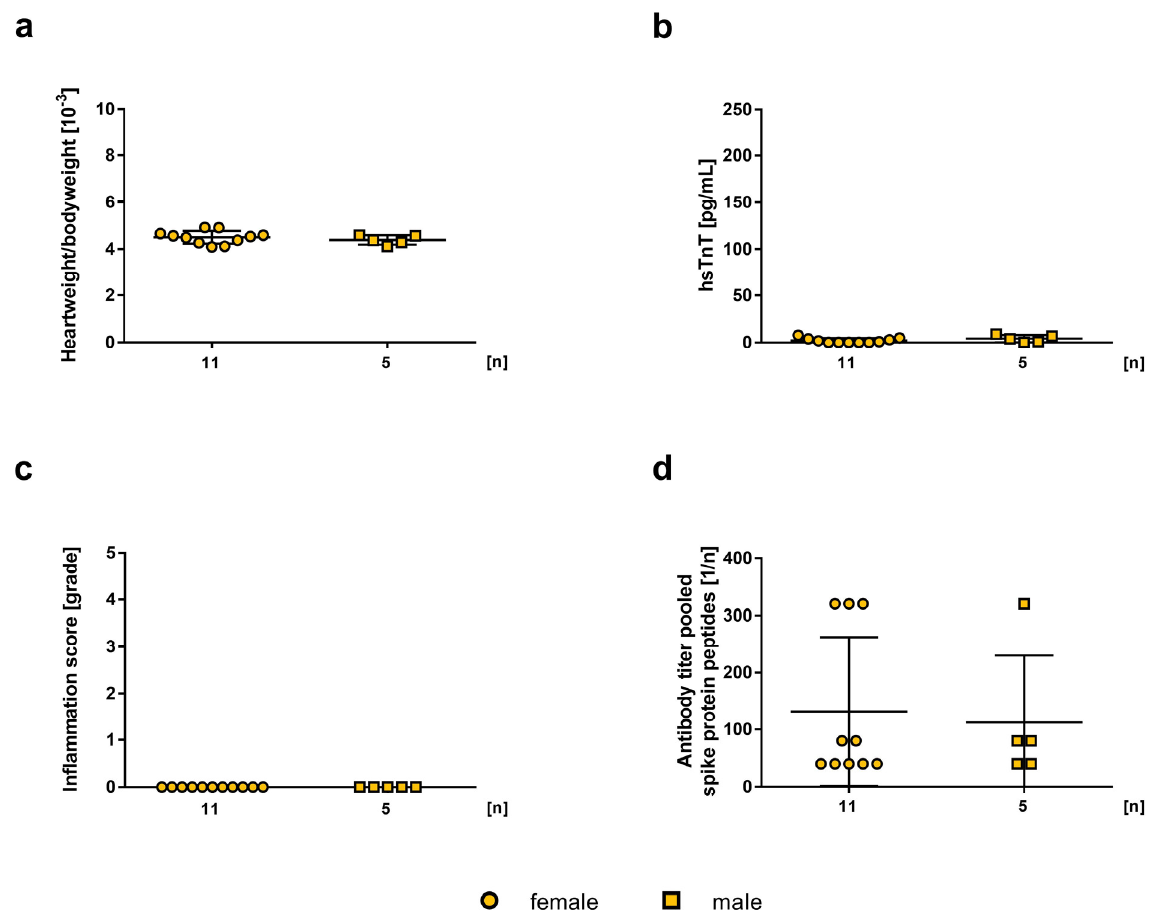
Figure 2. Effect of 2.5 µ g mRNA-vaccine on 5-weeks old female (n = 11) and male (n = 5) A/J wt mice. Data is presented as a mean ± SEM. ( a ) Calculated heart weight to body weight ratio on day 42. ( b ) Determination of hsTnT-values in mouse serum collected on day 42. ( c ) Histopathological examination of inflammation score in grades in HE stained heart sections on day 42, evaluated by two independent investigators. ( d ) Determination of produced antibodies against pooled spike protein peptide sequences in mouse serum on day 42 by ELISA.